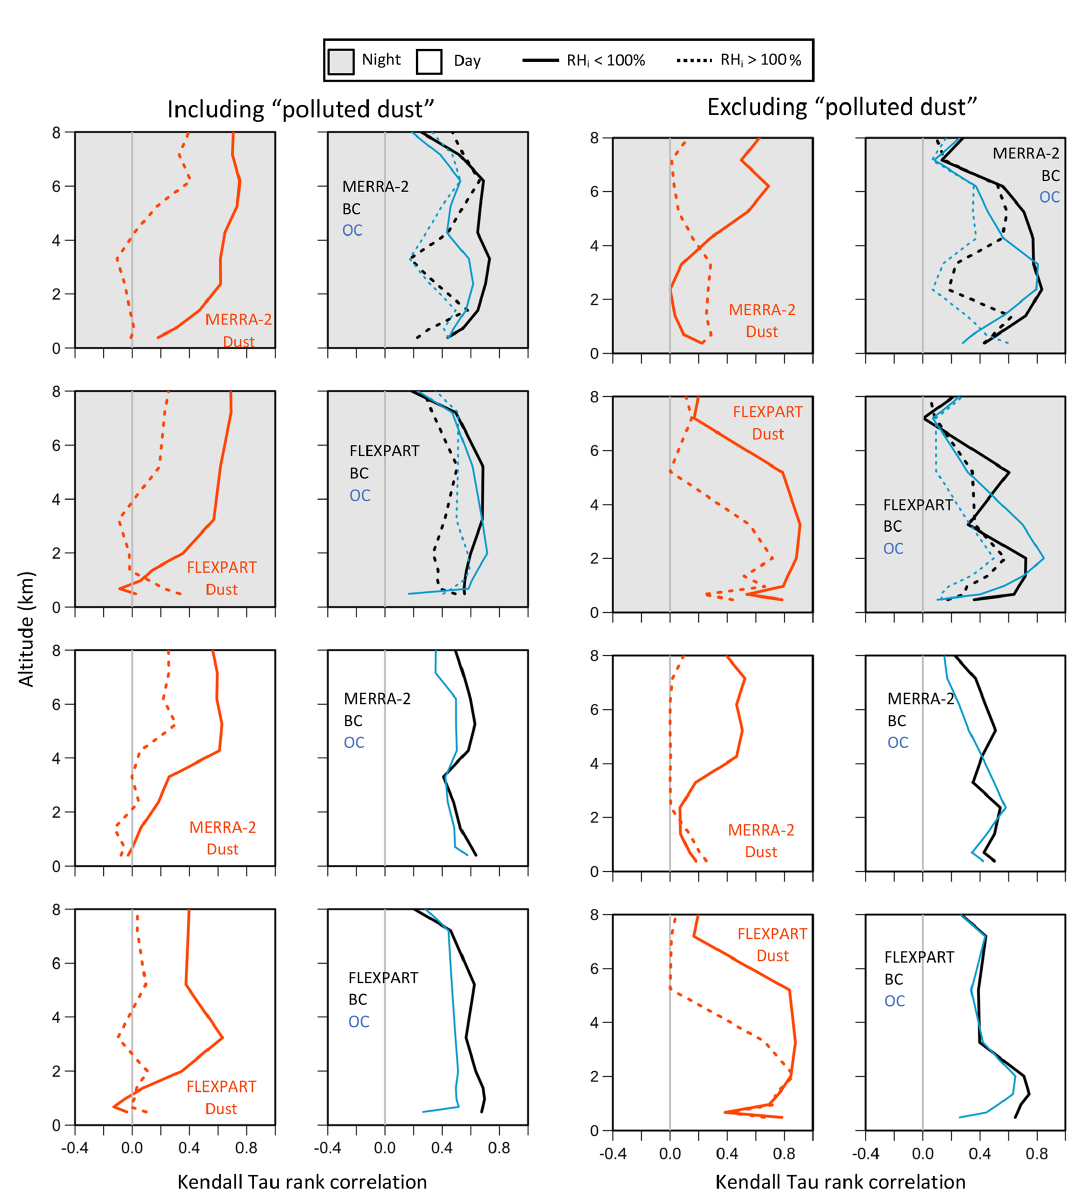
Figure 3. The Arctic-area-averaged Kendall tau rank correlation between mean CALIPSO aerosol layer fraction for dust (far left) and combustion aerosols (second column) with MERRA-2 and FLEXPART dust and black carbon (BC; black) and organic carbon (OC; blue) concentrations. The right two columns show the same information but with polluted dust excluded from both CALIPSO dust and combustion aerosol groups. Data are shown for nighttime (SZA > 90 ◦ ) and daytime (SZA < 90 ◦ ) conditions (grey and white backgrounds, respectively) and for conditions conducive to diamond dust formation (dashed lines). Model bins with < 30 observations were excluded in the averaging, which excludes < 1% of total model bins. Comparisons were made from 20 ◦ × 6 ◦ bin averages on cloud-free days, with the goal of capturing large-scale